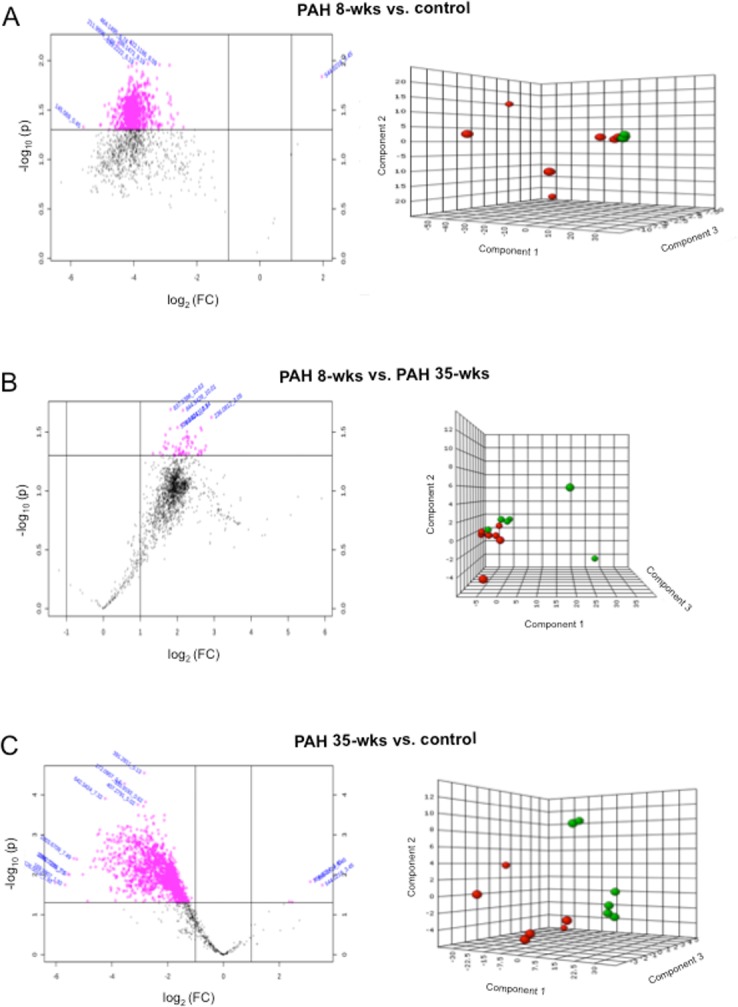
Metabolomics analysis of the lung.SU5416-injected rats were subjected to 3 weeks in hypoxia and then maintained in normoxia for 5 weeks (8-wks time point) or 32 weeks (35-wks time point). Metabolomics analysis was performed in the lung tissues. Volcano plots (on the left) and Partial least squares Discriminant Analysis (PLS-DA; on the right) for (A) 8-weeks PAH (green circles) vs. normal control (red circles), (B) 8-weeks PAH (green circles) vs. 35-weeks PAH (red circles) and (C) 35-weeks PAH (green circles) vs. normal control (red circles) are shown. Dot volcano plots represent fold changes (FC) on the x-axis and the statistical significance in P value on the y-axis. Pink dots represent values with P≤0.05 and changes of greater than twofold.